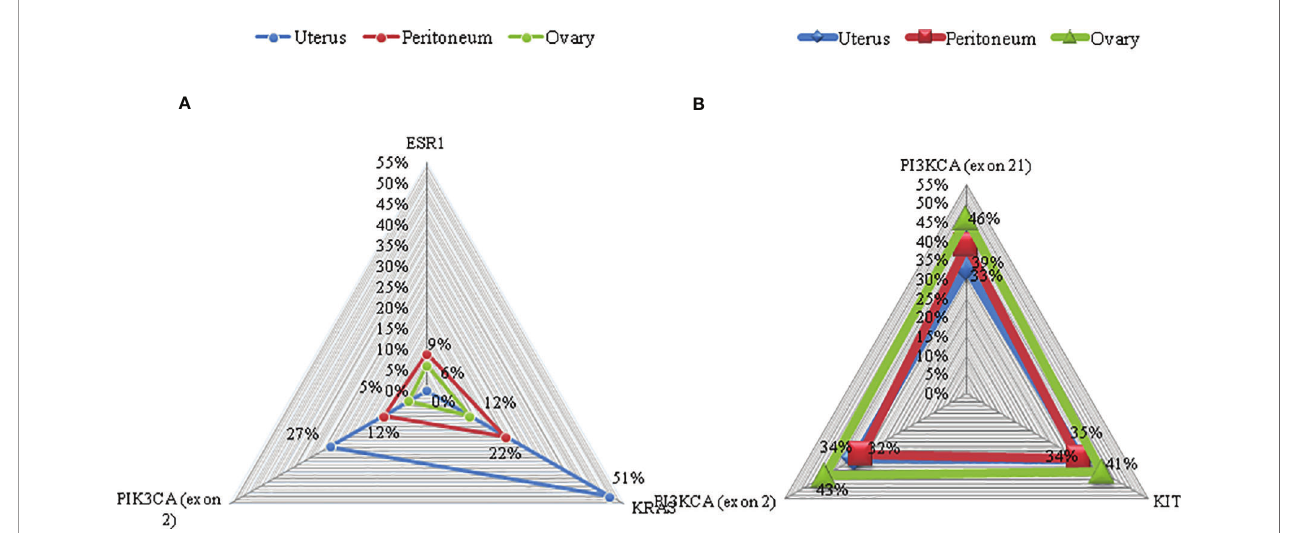
FIGURE 1 | Mutations on representative cancer-associated genes of case 1 (A) and case 2 (B) . Each color represents a different sample. Triangles represent the mutant allele frequency (MAF), corresponding to those of the vertical